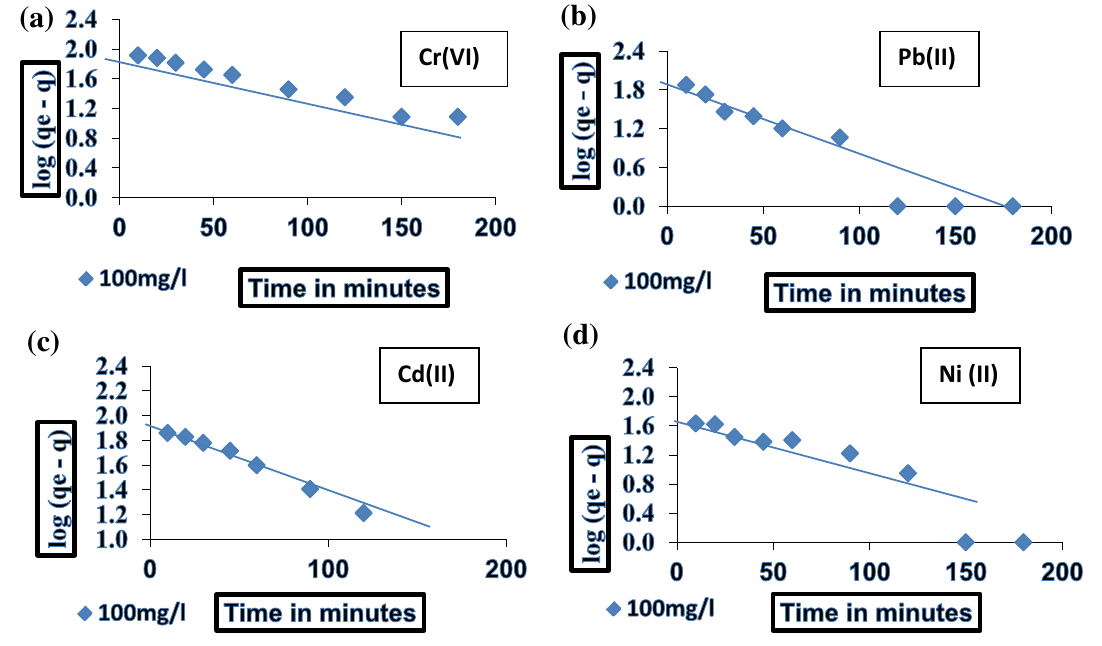
Fig. 2 First-order Lagergren ( a – d ) plots for CMAC on heavy metals adsorption Table 5 Lagergren’s rate equation Adsorbent Heavy metal